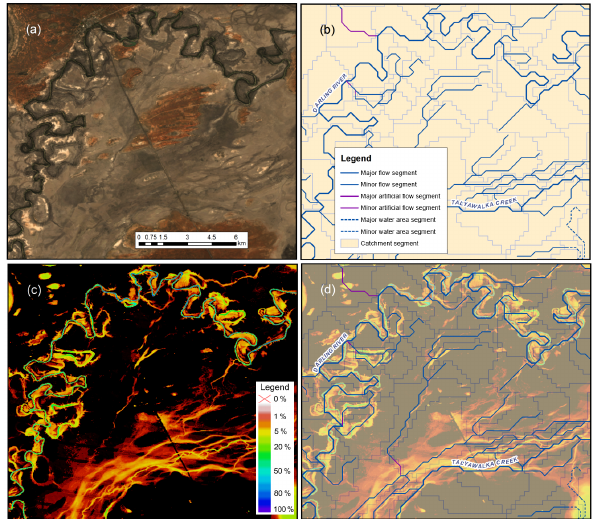
Figure 1. Illustration of the data used in the investigations: (a) true colour median-value composite of Landsat-8 data for a 15.7km × 15.3km area centered on 31.62 ◦ S and 143.42 ◦ N; (b) river segments and corresponding sub-catchment area from the Geofabric Surface Network; (c) WOfS water summary showing the percentage of times surface water was observed; and (d) overlay of the Geofabric onto WOfS (i.e. b and c